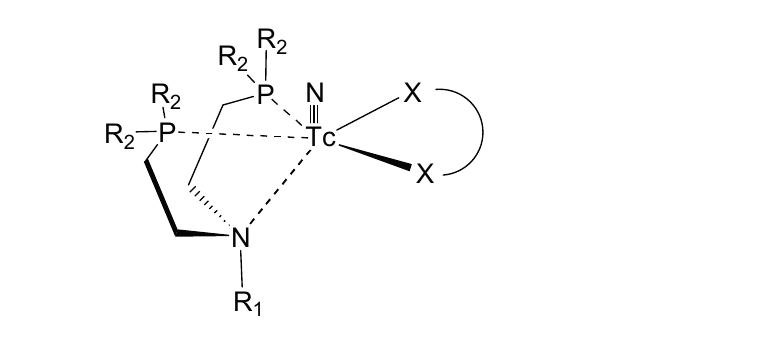
Figure 35. Schematic representation of the chelating core of PNP tridentate